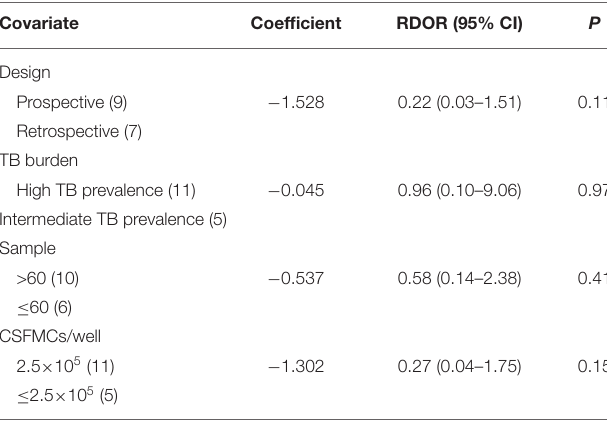
TABLE 3 | Weighted meta-regression to assess the effects of various factors on the diagnostic accuracy of CSF T-SPOT assay. Covariate